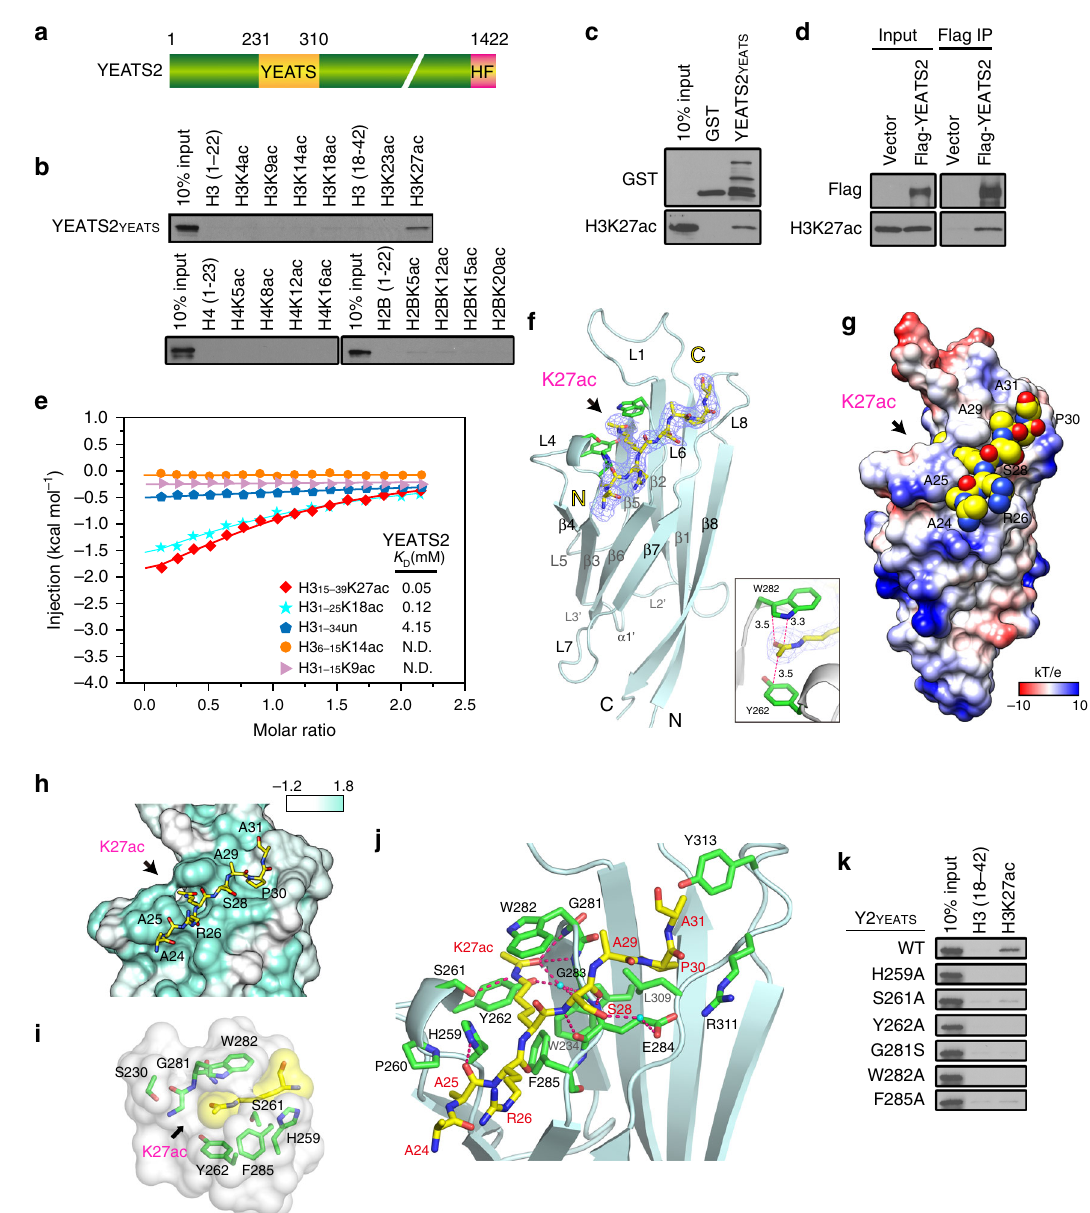
Fig. 3 The YEATS domain of YEATS2 recognizes H3K27ac. a Schematic representation of YEATS2 protein structure. The amino acid numbers of the YEATS domains and the full-length protein are shown. HF: histone fold domain. b Western blot analysis of histone peptide pulldowns of GST-YEATS2 YEATS domain and the indicated biotinylated peptides. c Western blot analysis of histone pulldowns of GST-YEATS2 YEATS domain or GST and calf thymus histones. The arrow indicates the band of the GST-YEATS YEATS2 domain. d Western blot analysis of Flag co-IP in 293 T cells transfected with Flag-YEATS2 or vector control. e ITC fi tting curves of YEATS2 YEATS titrated with H3 15 – 39 K27ac, H3 1 – 15 K18ac, unmodi fi ed H3 1 – 34 K27, H3 6 – 15 K14ac, and H3 1 – 15 K9ac peptides. f Overall structure of YEATS2 (aa201 – 332) bound to the H3 24 – 31 K27ac peptide in ribbon view. YEATS2 (pale cyan) is shown as ribbons, and the histone H3 peptide (yellow) is depicted as sticks. Purple mesh: F o – F c omit map around H3 24 – 31 K27ac peptide contoured at 1.8 σ level. Bottom right, close-up view of the Kac-sandwiching pocket; interplanar distances are labeled in the unit of angstrom. g YEATS2 – H3K27ac space- fi lling- surface view color-coded by electrostatic potential ranging from − 10 to 10 kT/e. h Conservation mapping around the H3-binding surface in YEATS2. White and cyan colors indicate low ( < 0.25) and high (1.0) sequence conservation, respectively. The H3K27ac peptide is shown in yellow stick. i Close-up view of the K27ac-binding pocket of the YEATS2 YEATS domain. The pocket is displayed as semi-transparent surface with key residues shown as green sticks. K27ac is depicted in both yellow stick and space- fi lling sphere modes. j Hydrogen bonding network between H3K27ac peptide and YEATS2. Hydrogen bonds are shown as pink dashes. Key residues of YEATS2 are depicted as green sticks and labeled black; the H3 peptide is shown as yellow sticks and labeled red. k Western blot analysis of peptide pulldowns of WT YEATS2 YEATS domain or the indicated point mutants with the H3K27ac peptide